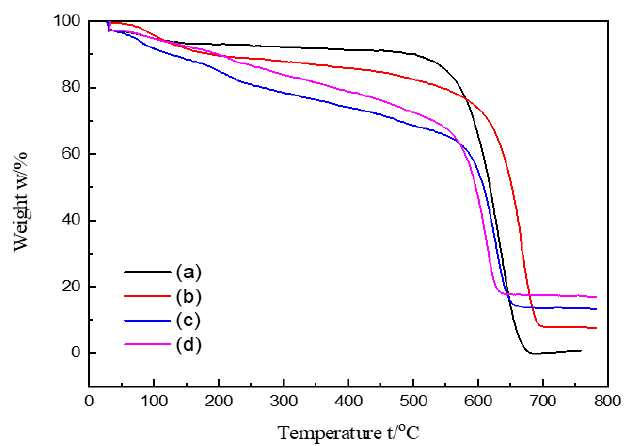
Figure 5. TGA thermograms of ( a ) MWCNTs, ( b ) MWCNT-COOH, ( c ) MWCNT-CH 2 OH, and ( d ) MWCNT-CH 2 OCOC 12 H 23 O 3 .